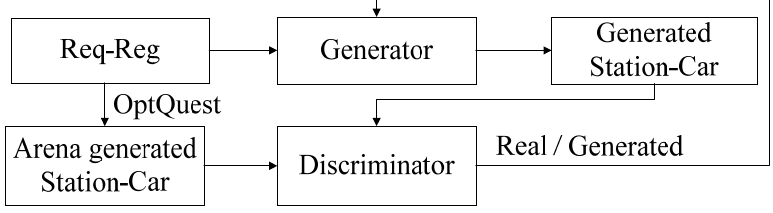
Figure 11. GAN architecture used for training.